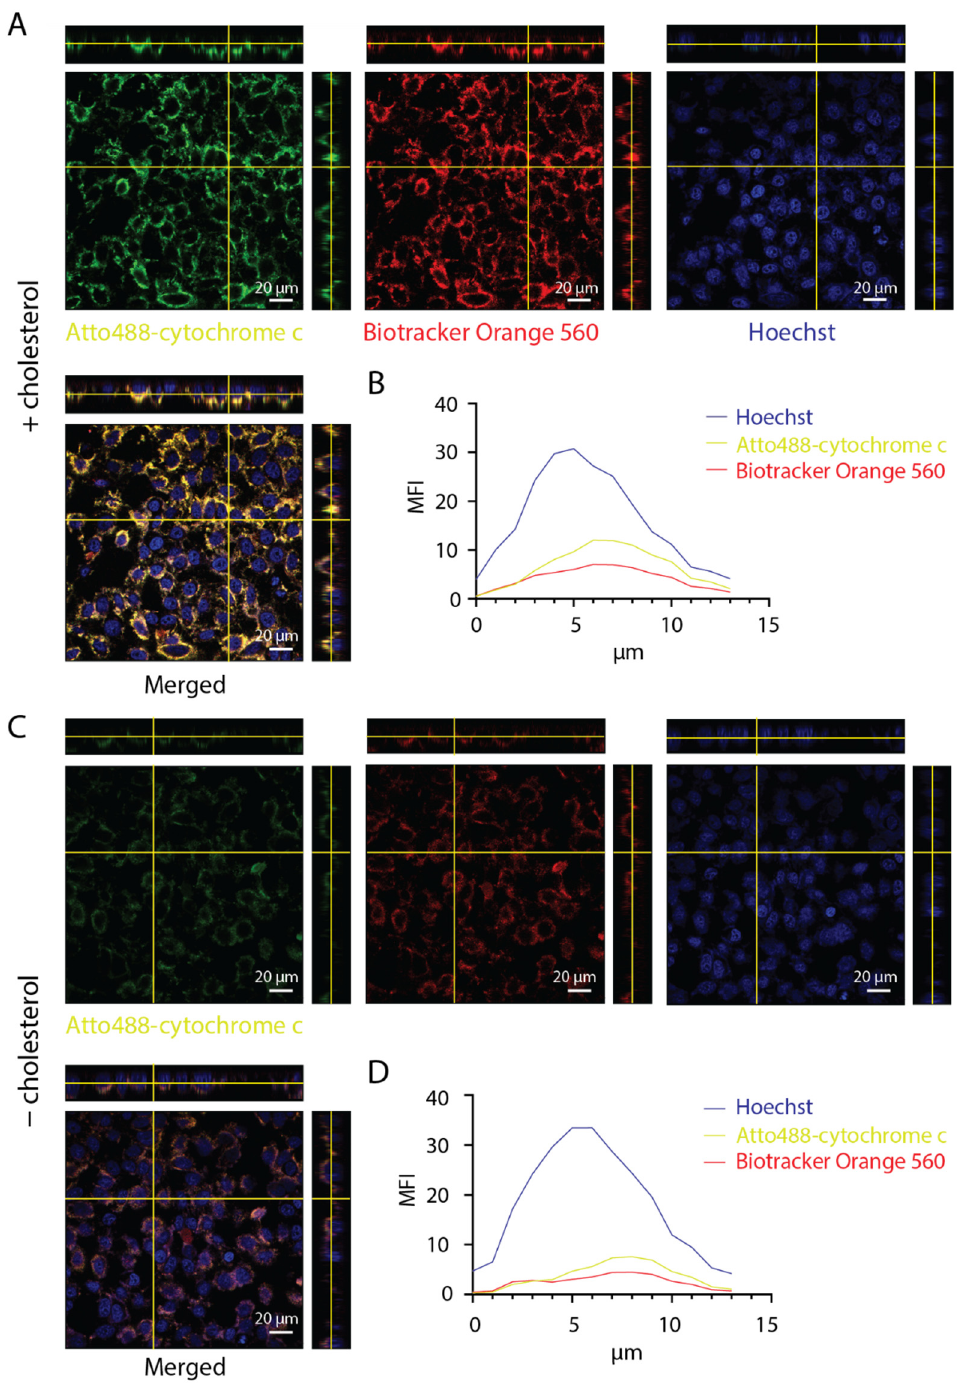
Figure A4. Internalization of cytochrome c-conjugated DNA nanotubes. ( A ) Orthogonal xz and yz cross sections of cells treated with cholesterol-conjugated DNA nanotubes. ( B ) Fluorescent intensity profile of the respective z -stack image. ( C ) Orthogonal xz and yz cross sections of cells treated with DNA nanotubes without cholesterol molecules. ( D ) Fluorescent intensity profile of the respective z -stack image. Scale bar: 20 µm.